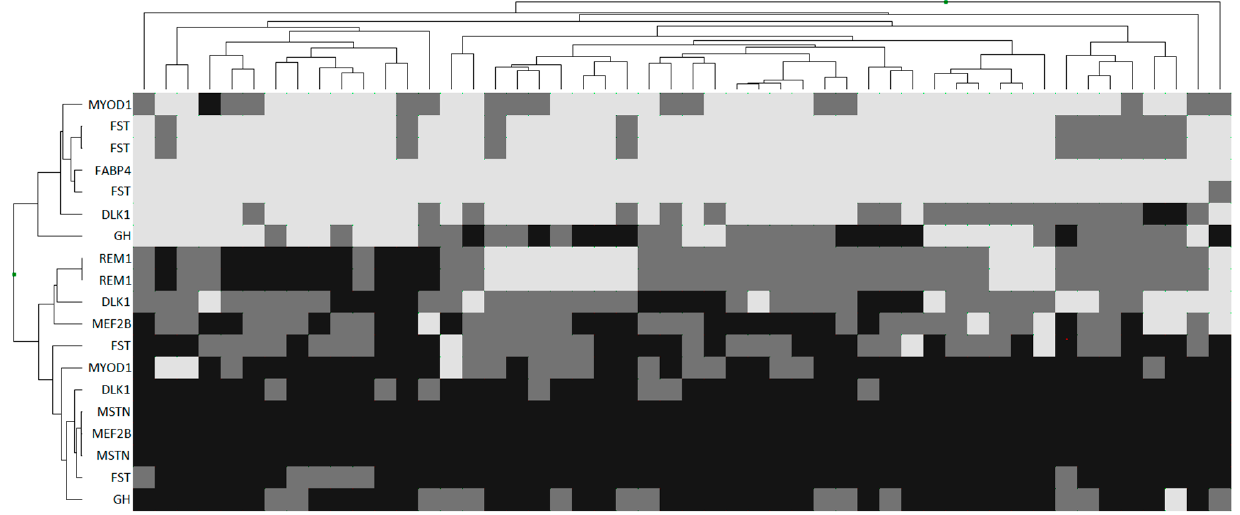
Figure 3. Heatmap of no association with meat production trait gene polymorphisms in Jalgin merino. Clustered individual genotypes. Light grey: wild homozygote; grey: heterozygote; dark grey: mutant homozygote.